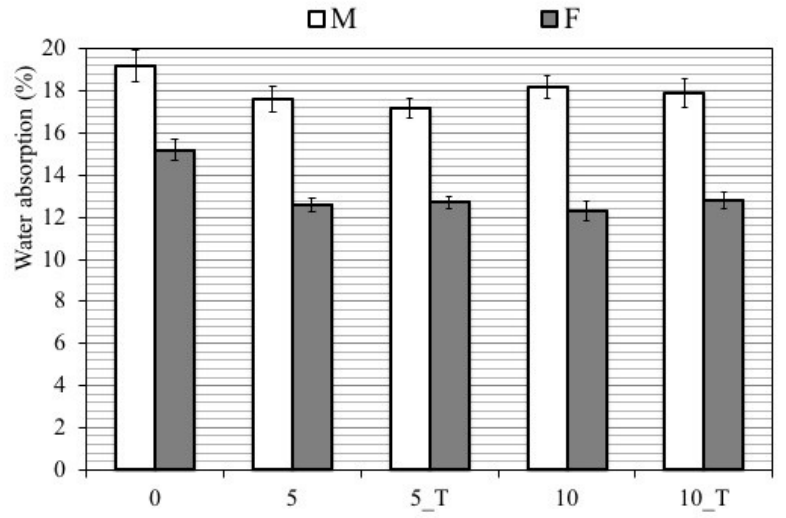
Figure 4. Water absorption of the investigated materials.